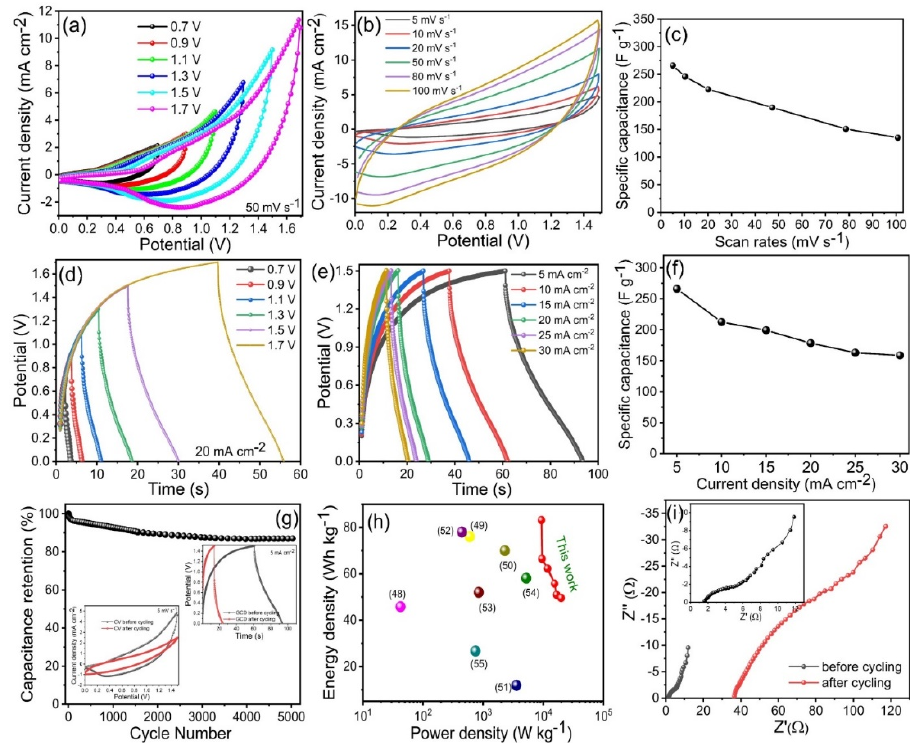
Figure 8. ( a ) CV curves of the asymmetric hybrid Co 2 P 2 O 7 //AC SC device at a different potential window at a constant scan rate of 50 mV s − 1 , ( b ) CV curves of hybrid Co 2 P 2 O 7 //AC SC device at a constant potential window 1.5 V, with various scan rate 5–100 mV s − 1 , ( c ) specific capacitance of the hybrid Co 2 P 2 O 7 //AC SC device at various scan rates, ( d ) GCD curves of the hybrid Co 2 P 2 O 7 //AC SC device at a different potential window at a constant current density of 20 mA cm − 2 , ( e ) GCD curves of the hybrid Co 2 P 2 O 7 //AC SC device at a constant potential window 1.5 V, with different current densities 5–30 mA cm − 2 , ( f ) specific capacitance of the hybrid Co 2 P 2 O 7 //AC SC device at different current densities 5–30 mA cm − 2 , ( g ) cycling stability of the hybrid Co 2 P 2 O 7 //AC SC device up to 5000 cycles, inset shows the CV and GCD curves of the lower scan rate (5 mV s − 1 ) and current density (5 mA cm − 2 ), ( h ) Ragone plot, ( i ) EIS of the hybrid Co 2 P 2 O 7 //AC SC device before and after cycling stability testing.